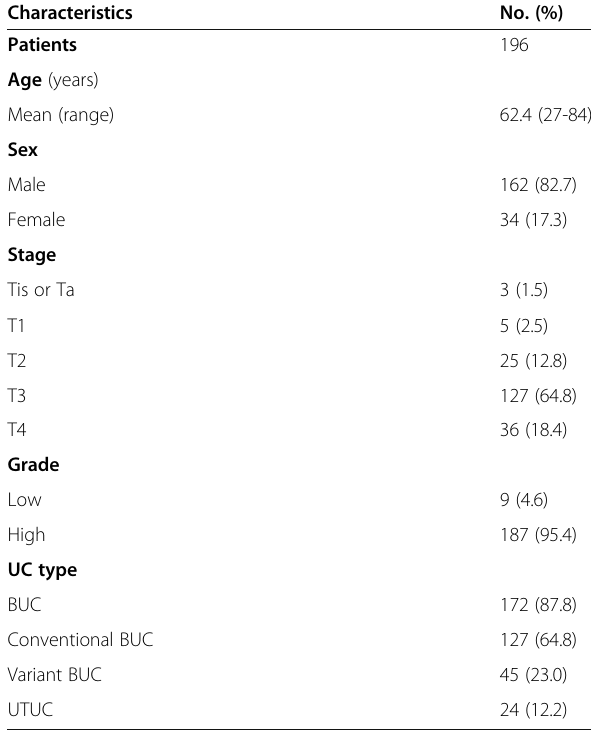
Table 1 Pathologic and clinical features of patients with primary UC